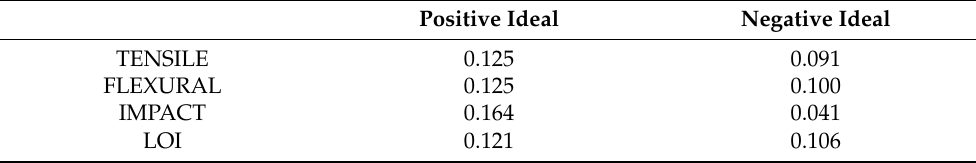
Table 9. The positive and negative ideal values.